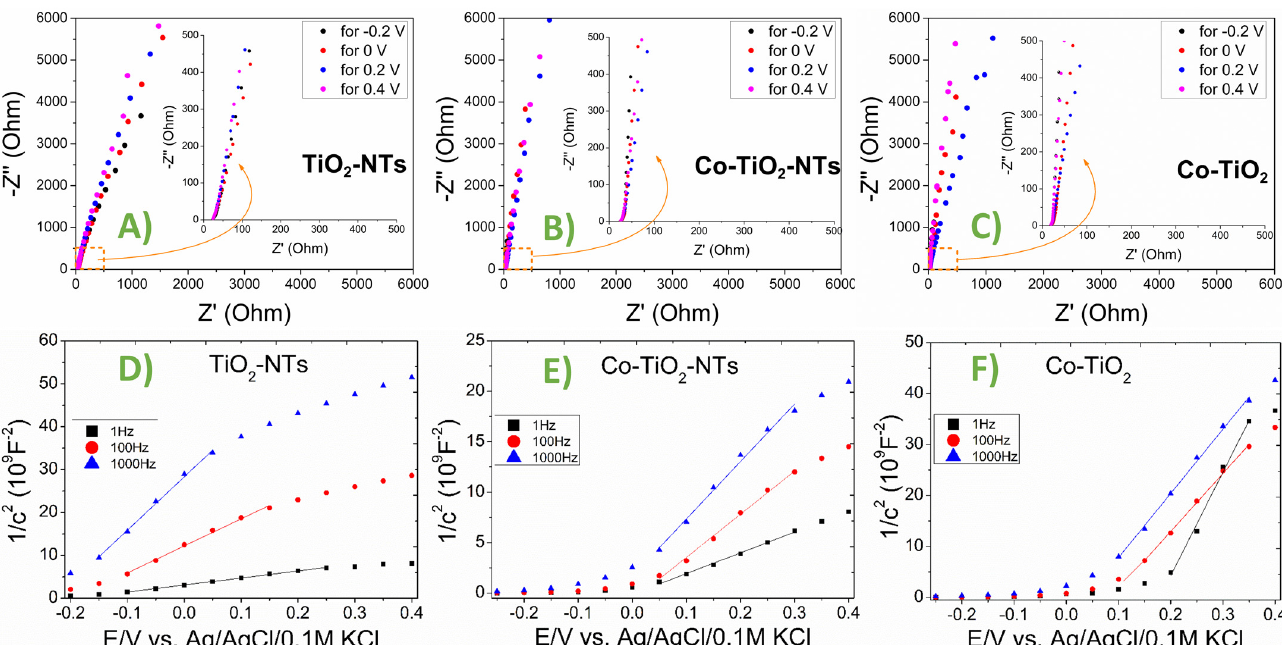
Figure 8. Complex plane impedance plots obtained for: ( A ) TiO 2 -NTs, ( B ) CoTiO 2 and ( C ) Co-TiO 2 , frequency range 20 kHz to 1 Hz. Mott–Schottky plots for: ( D ) TiO 2 -NTs, ( E ) CoTiO 2 , ( F ) Co-TiO 2 .